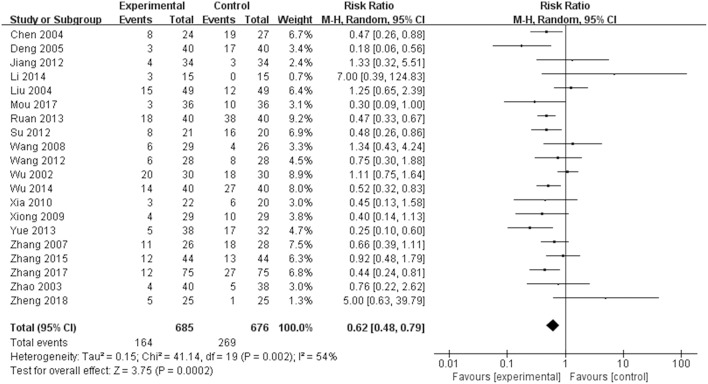
Total AEs of TGP on AS. Forest plots comparing TGP group and control group. TGP, total glucosides of peony; AS, ankylosing spondylitis.